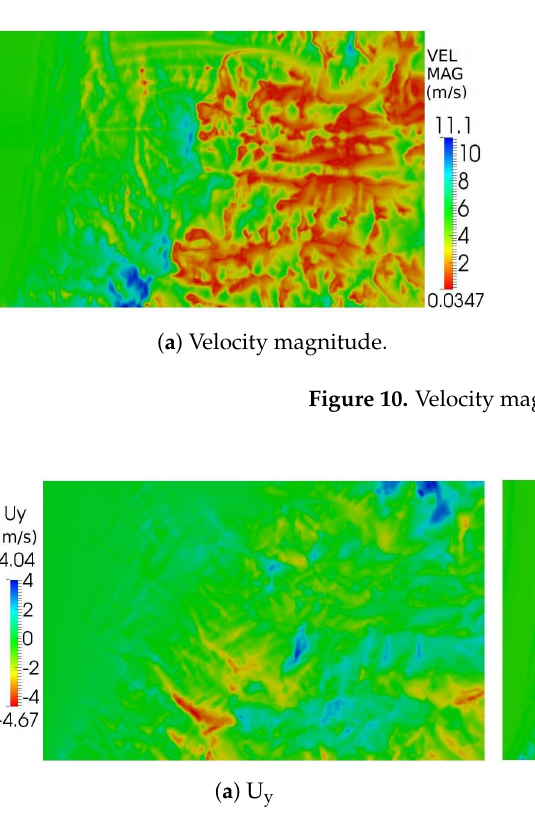
Figure 11. Velocity components in y - and z -direction at 30